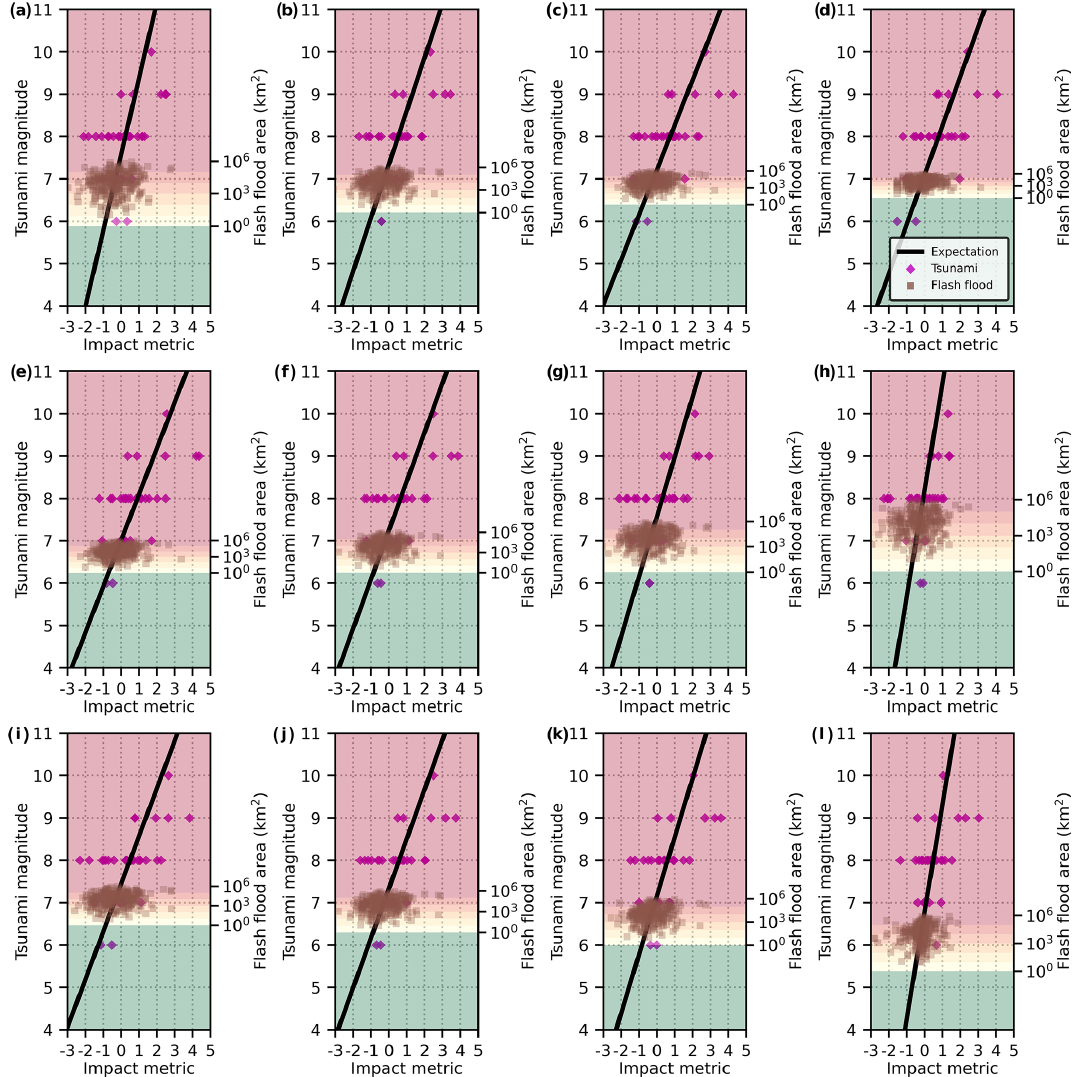
Figure 8. Results of visual sensitivity analysis regarding effects of altering weight of one transformed impact variable within impact metric on equivalent magnitudes of tsunami and flash flood events. Weight of fatality equals zero, (d) , respectively, where w F is the calibrated weight of fatality. Weight of total affected population equals zero, one in (e) , (f) , (g) , and (h) , respectively, where w TA is the calibrated weight of total affected population. Weight of total damage equals zero, (cid:114) (cid:16) (cid:113) (cid:17) + 1 w 2 / 2, w 2 / 2, and one in (i) , (j) , (k) , and (l) , respectively, where w TD is the calibrated weight of total damage. In panels (a) – (l) , TD TD sum of squared weights of three transformed impact variables equals one and the ratio of squares of the other two variable weights is kept